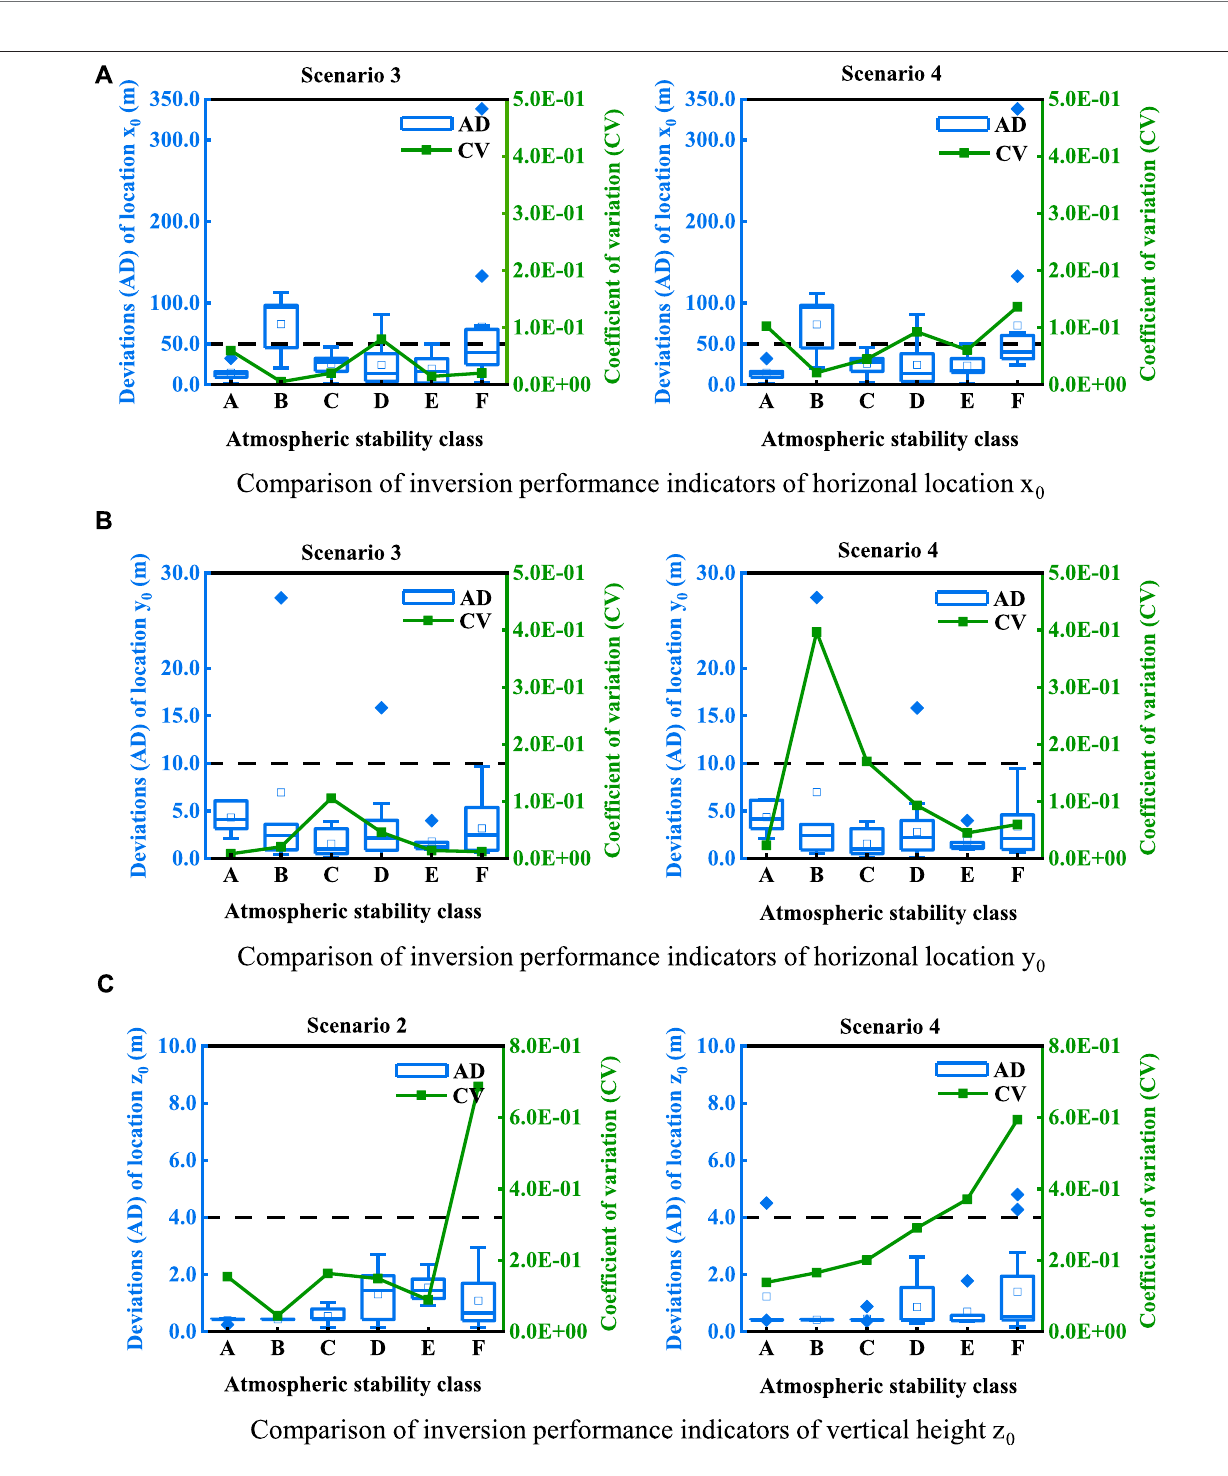
FIGURE 6 | Boxplots of the inversion accuracy index (AD) and line charts of the inversion robustness index (CV) for source location (i.e., x 0 , y 0 , and z 0 ) estimation. (A) Comparisonofinversionperformanceindicatorsofthehorizontallocationparameterx 0 , (B) comparisonofinversionperformanceindicatorsofthehorizontallocation parameter y 0 , and (C) comparison of inversion performance indicators of the vertical height parameter z 0 .